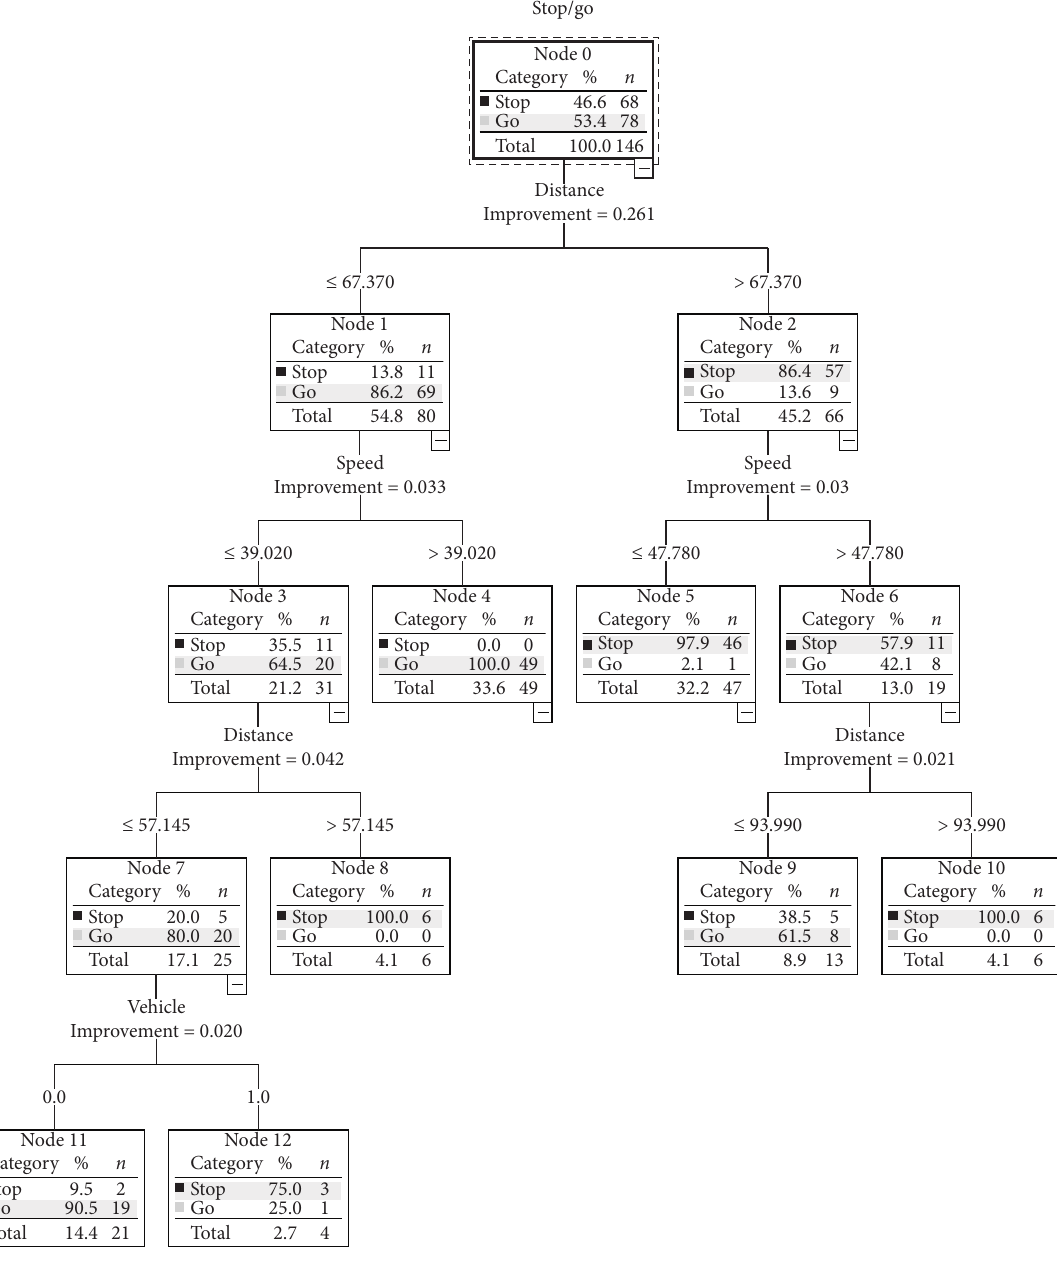
Figure 6: DTC analysis results for urban intersections (training